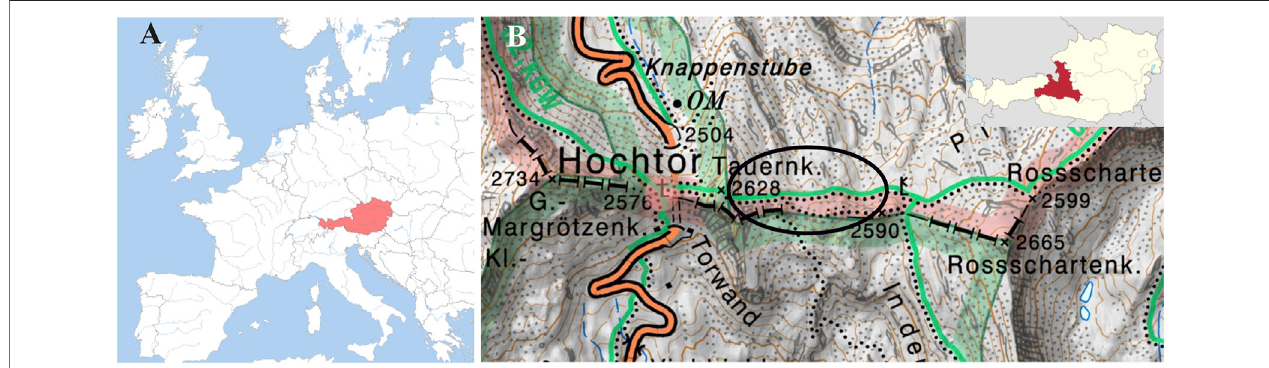
FIGURE1| Location ofthestudy. (A) GeographicalpositionofAustria(red) withinEurope.(https://commons.wikimedia.org/wiki/File:Austria_in_Europe.svg, scale 1:29.000.000). (B) StudyareaneartheHochtorontheGrossglocknerhighalpineroute(bergfex.at,Austrianmap1:50.000,blackovaloutline,scale1:10.000).Topright: Austria and Province Salzburg (red) (File: Salzburg in Austria.svg., scale 1: 13.000.000).